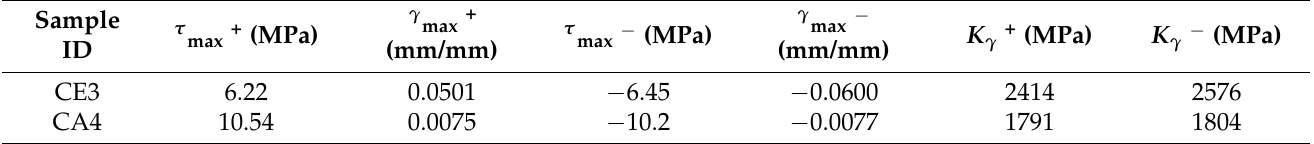
Table 5. Critical NLFEA points for uncorroded specimens (CE3 and